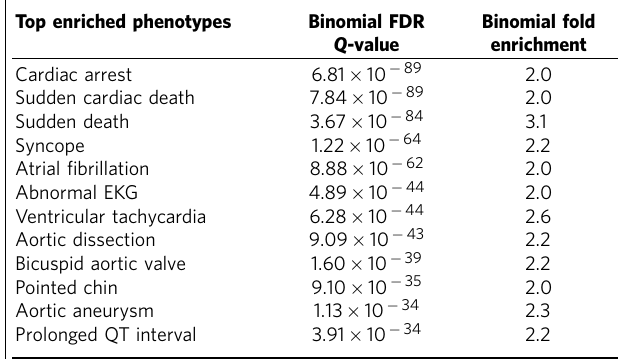
Table 2 | Top enriched human phenotypes of putative target genes near predicted heart